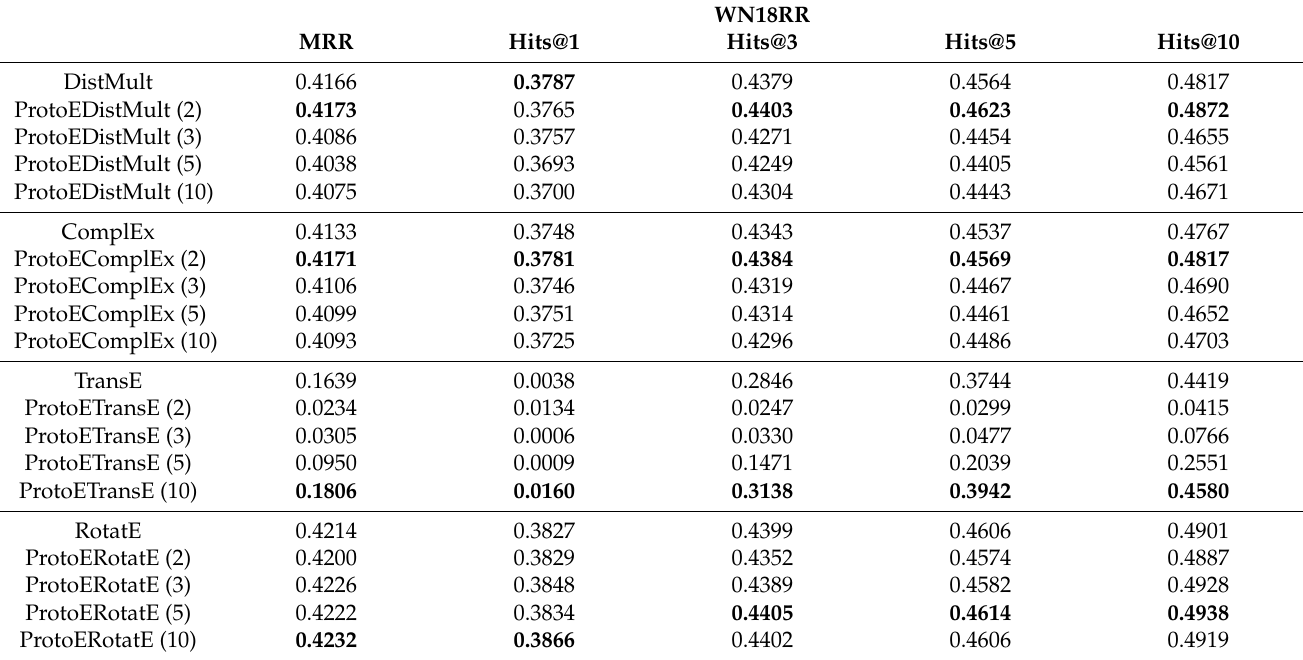
Table 6. Results of ablation experiments for prototype embedding on WN18RR. Best values are indicated in bold.